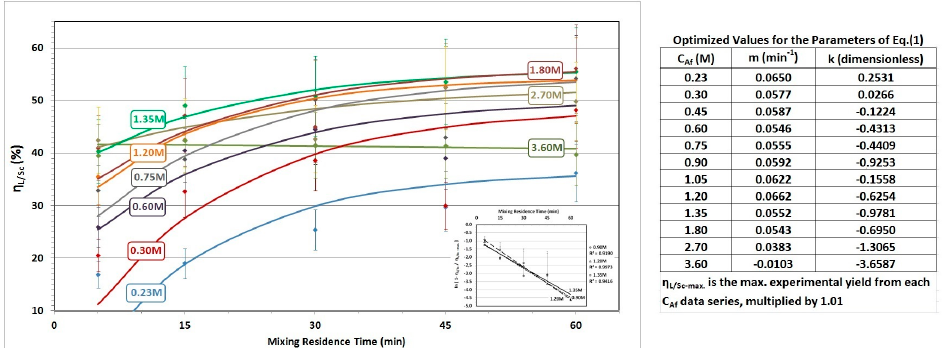
Figure 1. Variation of Sc leaching yield ( η L/Sc ) with mixing residence time and feed acid (sulfuric) concentration under constant L/S = 50. The colored curves show 1st order kinetics fittings to the relevant experimental data [ η L/Sc = η L/Sc − max ( 1 − e − mt + k ) ]. Appended graph: logarithmically linearized 1st order kinetics, in terms of Sc leaching yield, for three feed acid concentrations.